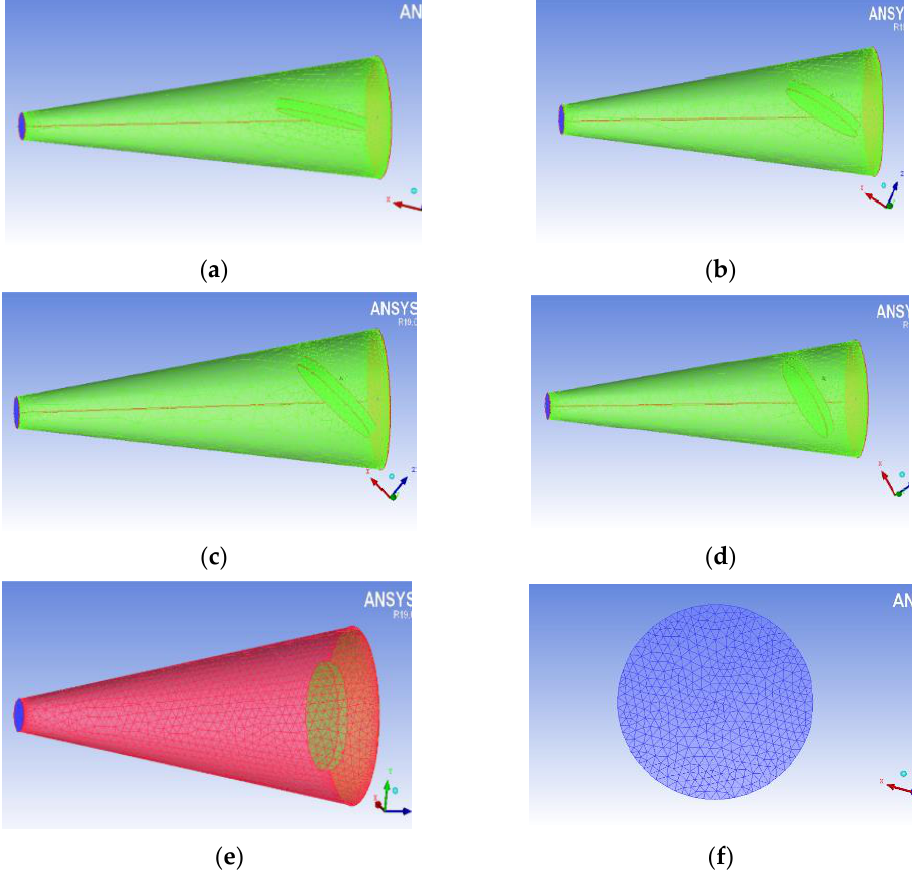
Figure 2. Mesh of models with different particle impact angle. ( a )15°; ( b )30°; ( c )45°; ( d )60°; ( e )90°; ( f ) Cross-sectional slices.